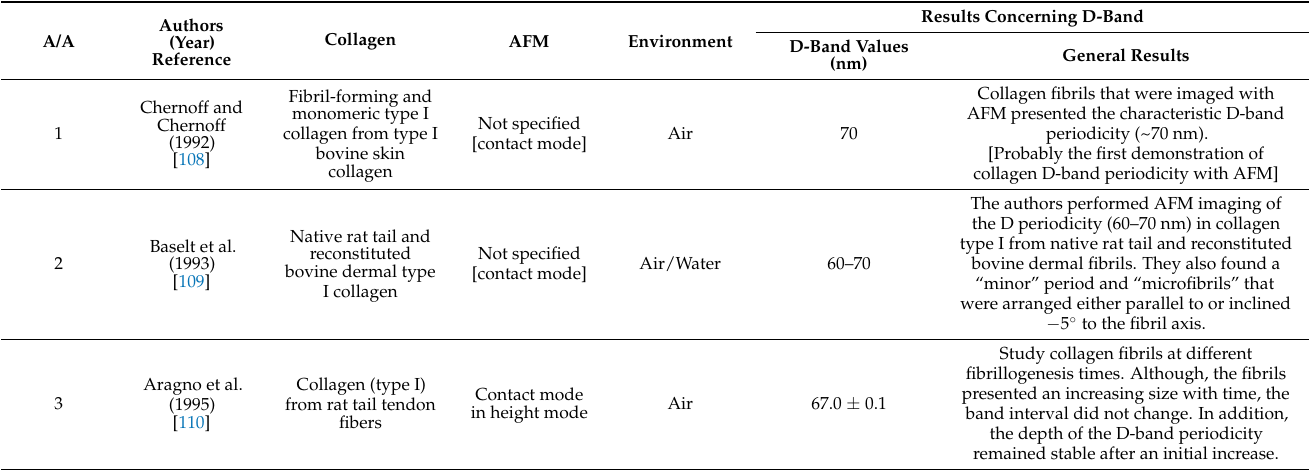
Table 2. Major information from the publications that were found through literature